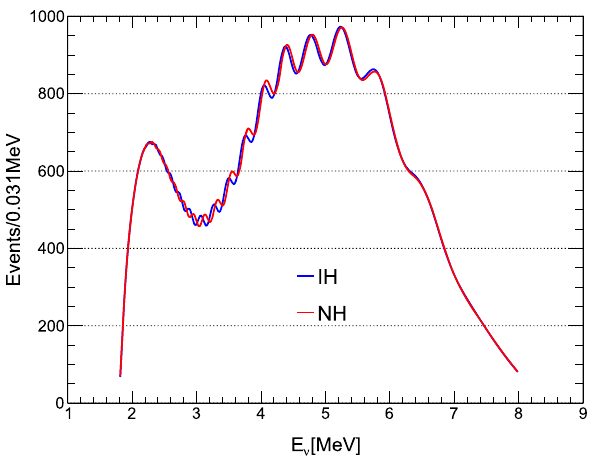
Fig. 1 Expectedreactorneutrinoenergyspectrumobservedbyadetec- tor with 3% energy resolution locating at 52.5 km. The red (blue) curve corresponds to the NH(IH) assumption. In our simulation, the NH (and also IH) spectrum is generated based on the Daya Bay measured spec- trum (un-oscillated) [38], which will be discussed in details in the fol- lowing sections. A medium-baseline reactor neutrino oscillation exper- iment(s) is expected to observe the subdominant θ 13 oscillation and distinguish the tiny differences between the blue and red curves